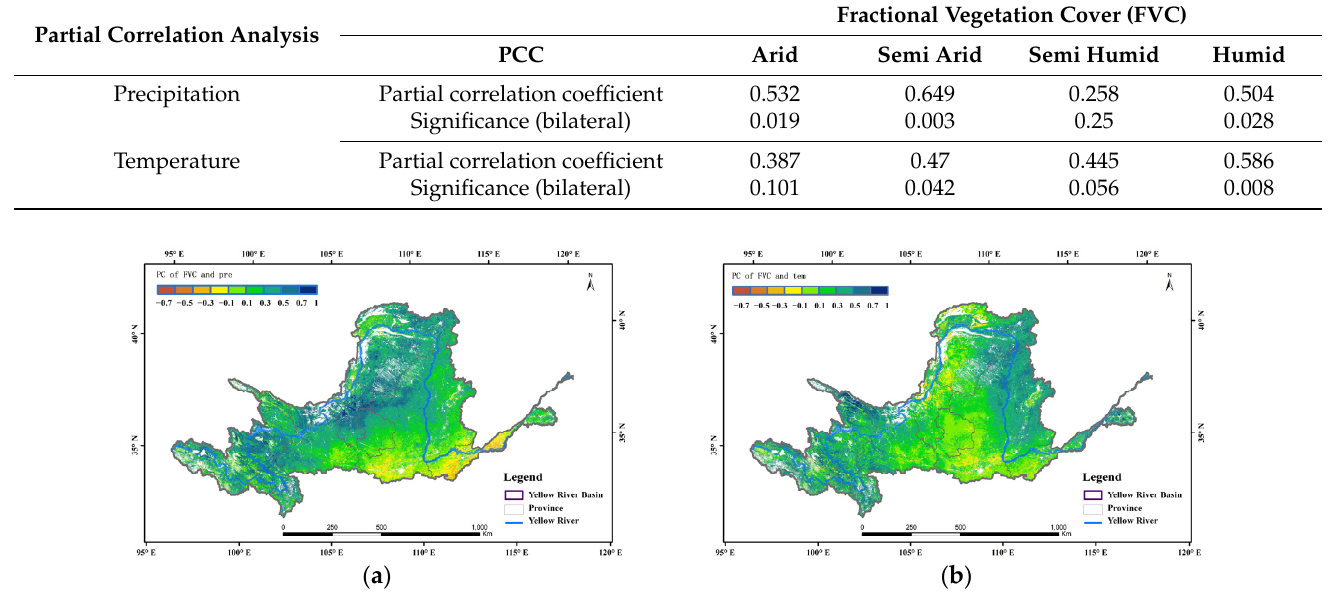
Figure 10. PC is the partial correlation coefficient. ( a ) The spatial distribution map of the partial correlation coefficient of FVC with precipitation. ( b ) The spatial distribution map of the partial correlation coefficient of FVC with temperature.